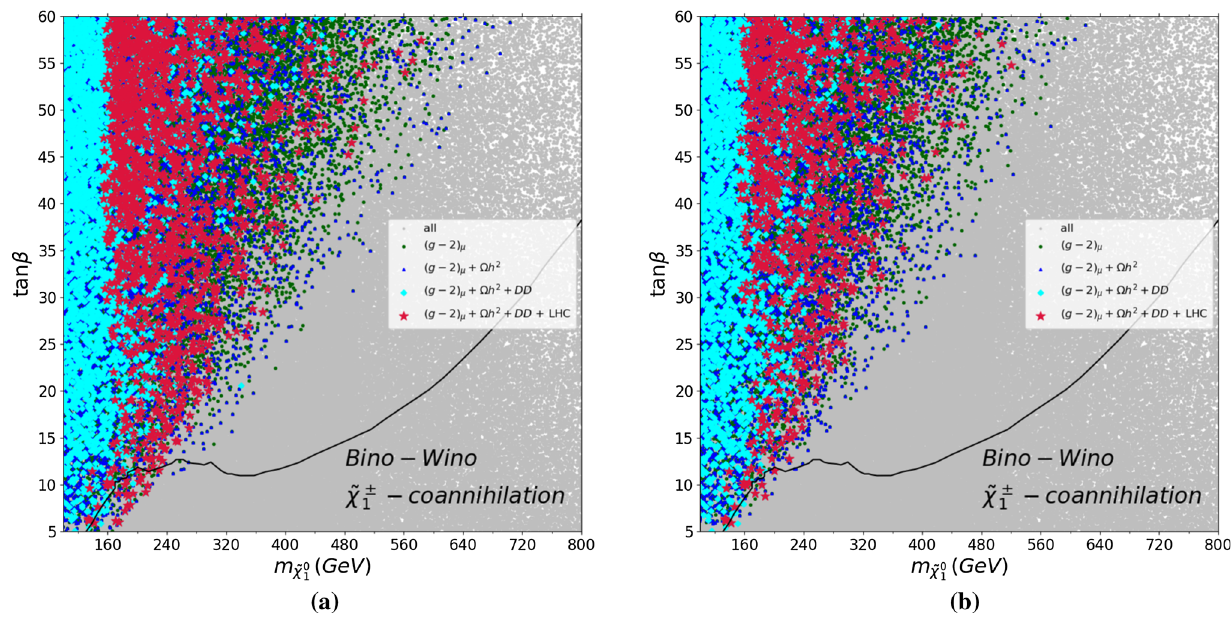
Fig. 14 Theresultsofourparameterscaninthe m ˜ χ 0 bino-wino ˜ χ ± -coannihilation scenario for current (left) and anticipated 1